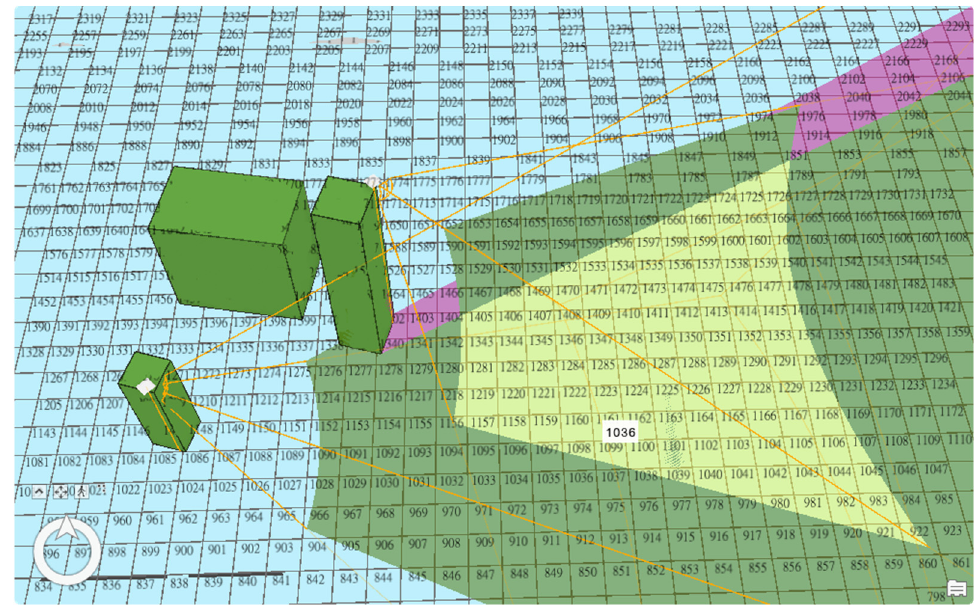
Figure 20. Integration of grid-cell and FOV